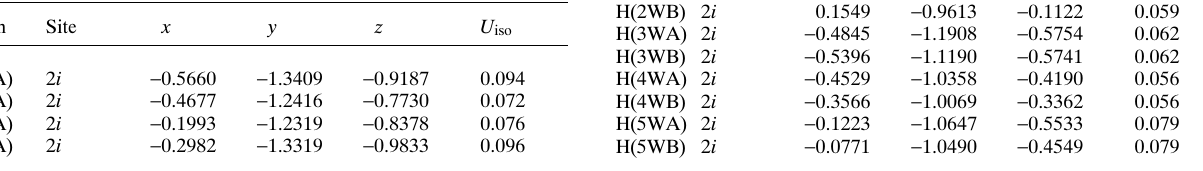
Table 2. Atomic coordinates and displacement parameters (in Å 2 ) .